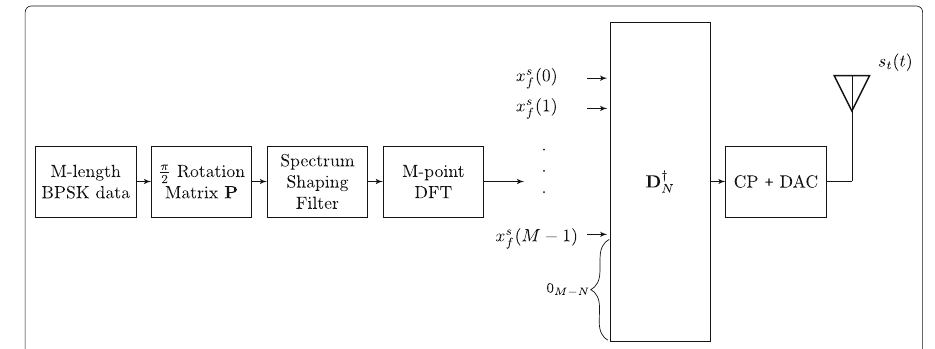
Fig. 10 Transmitter architecture for data waveform generation using method 2